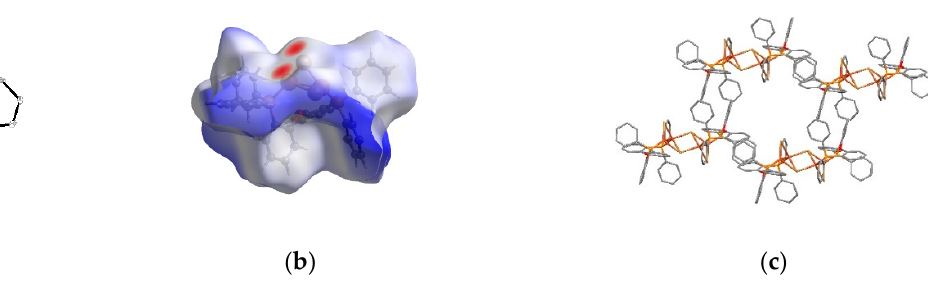
Figure 1. Single crystal structure of CuPBr ( a ), its Hirshfeld surface plotting ( b ) and its packing mode ( c ).